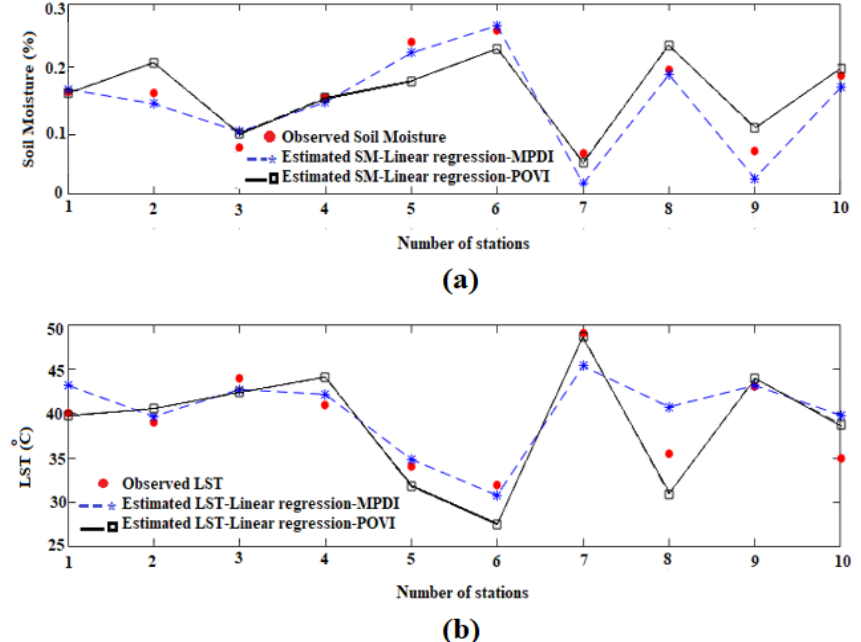
Figure 6. Comparison between observed and estimated Soil moisture ( a ) and Land surface temperature ( b ) parameters using POVI and MPDI in linear relationship.